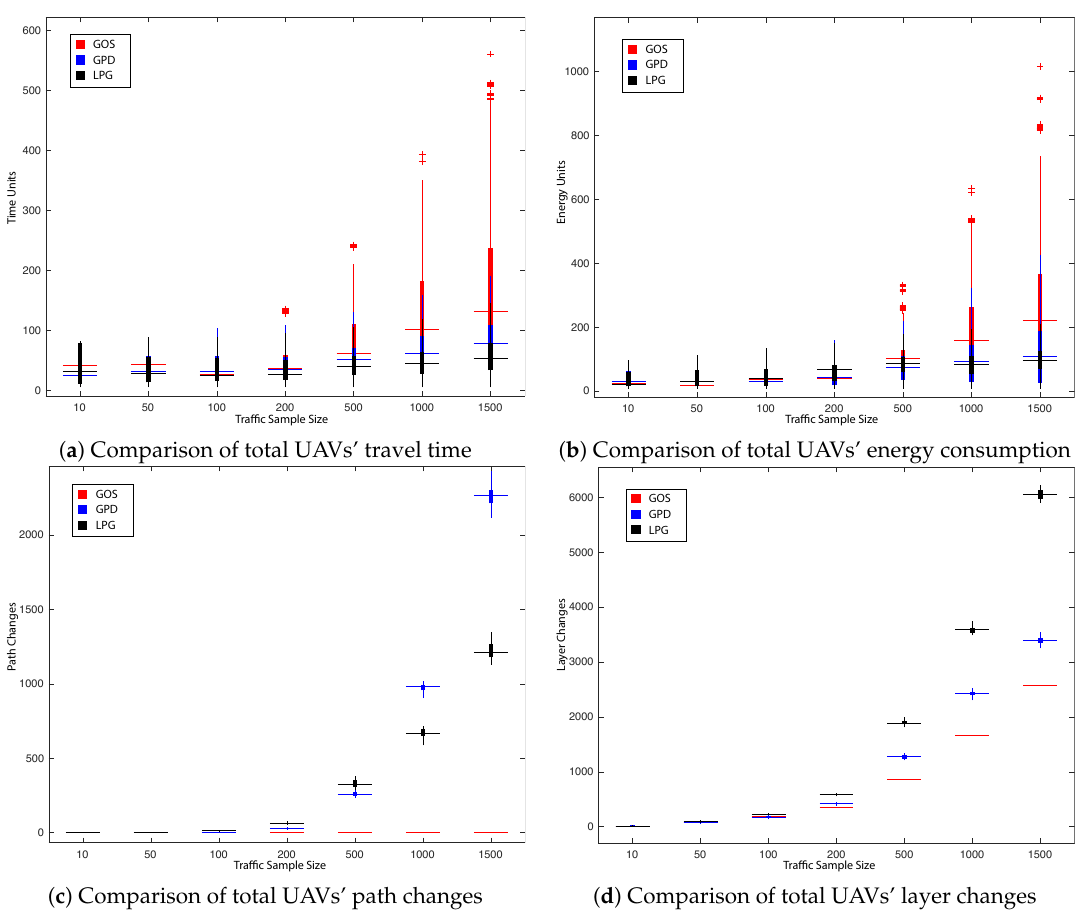
Figure 11. Performance comparison of Global Offline Static (GOS), GPD and